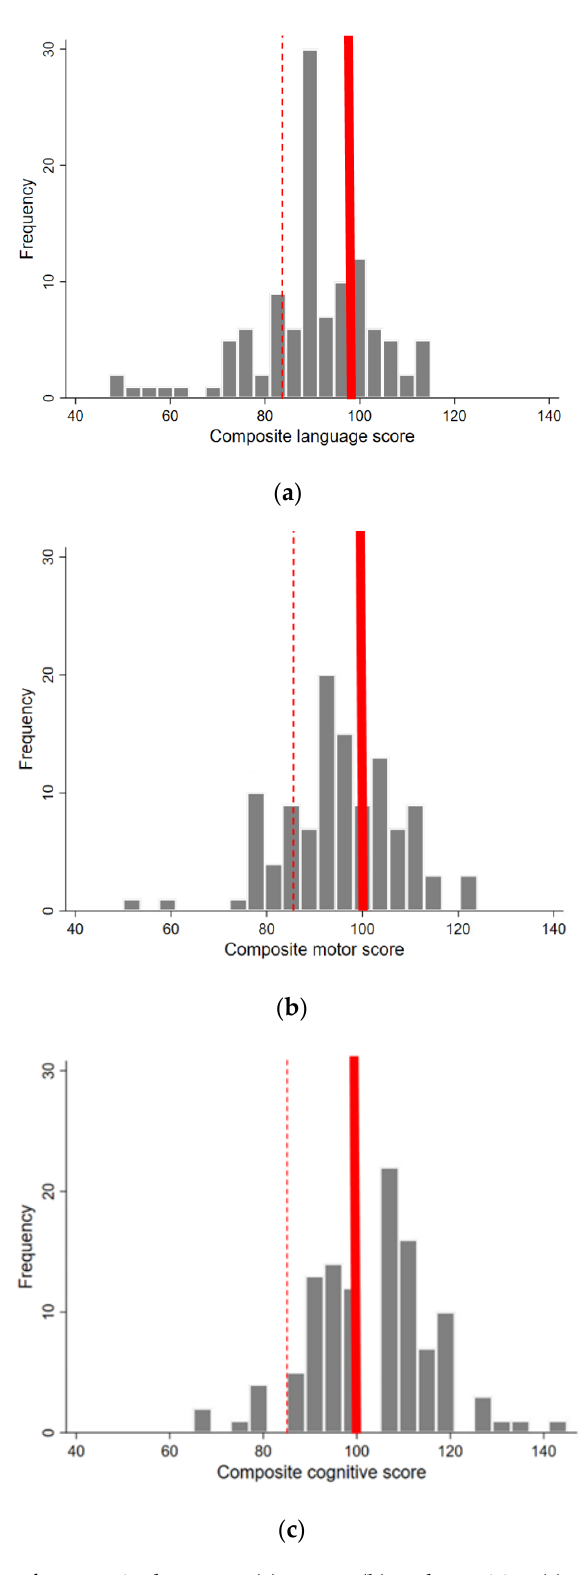
Figure 3. Histograms of composite language ( a ), motor ( b ) and cognitive ( c ) scores from Bayley-III assessments (thick red lines indicate the mean in a normative population (100) and dotted red lines indicate the threshold for developmental delay (at risk or severely delayed) at 1 or more SD below the mean (i.e., a score ≤85)).